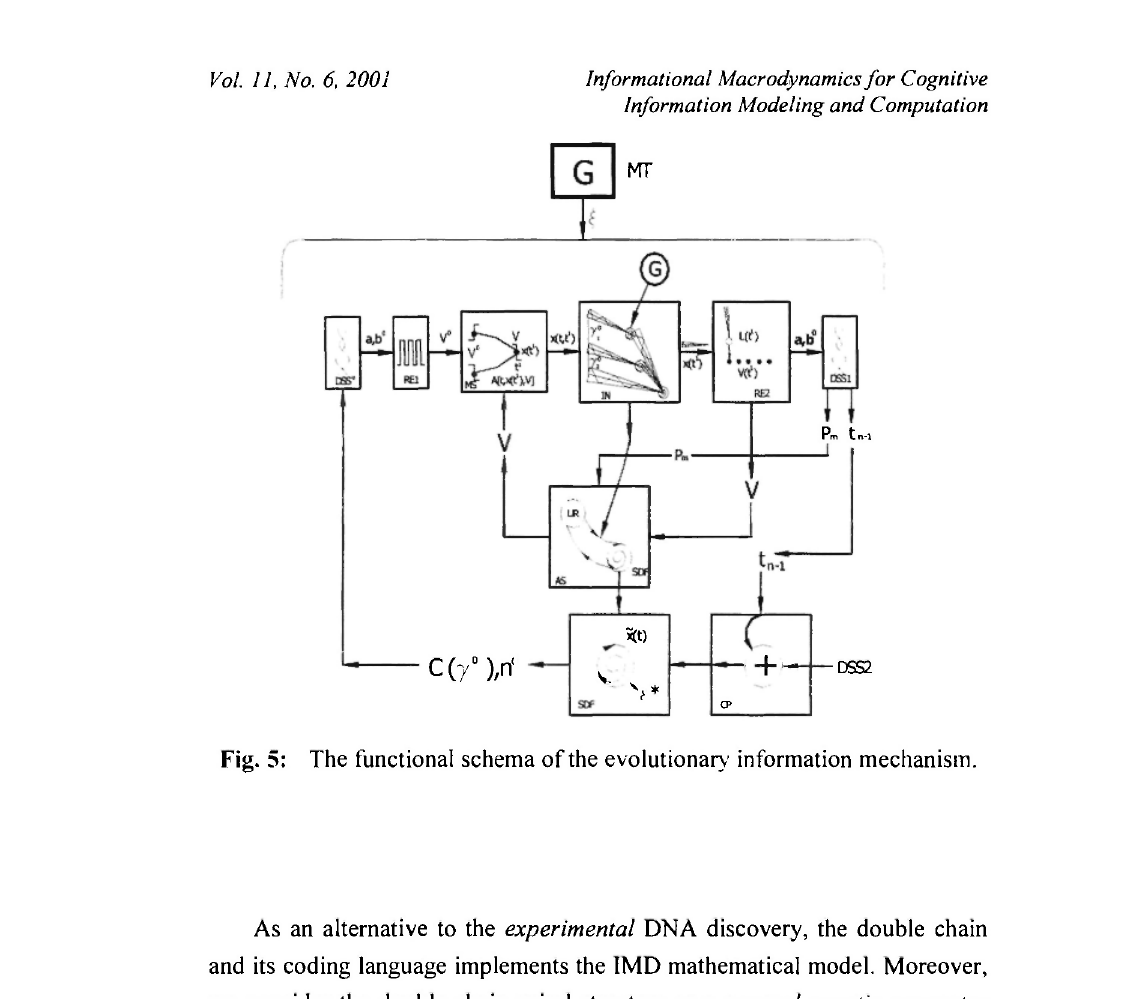
As an alternative to the experimental DNA discovery, the double